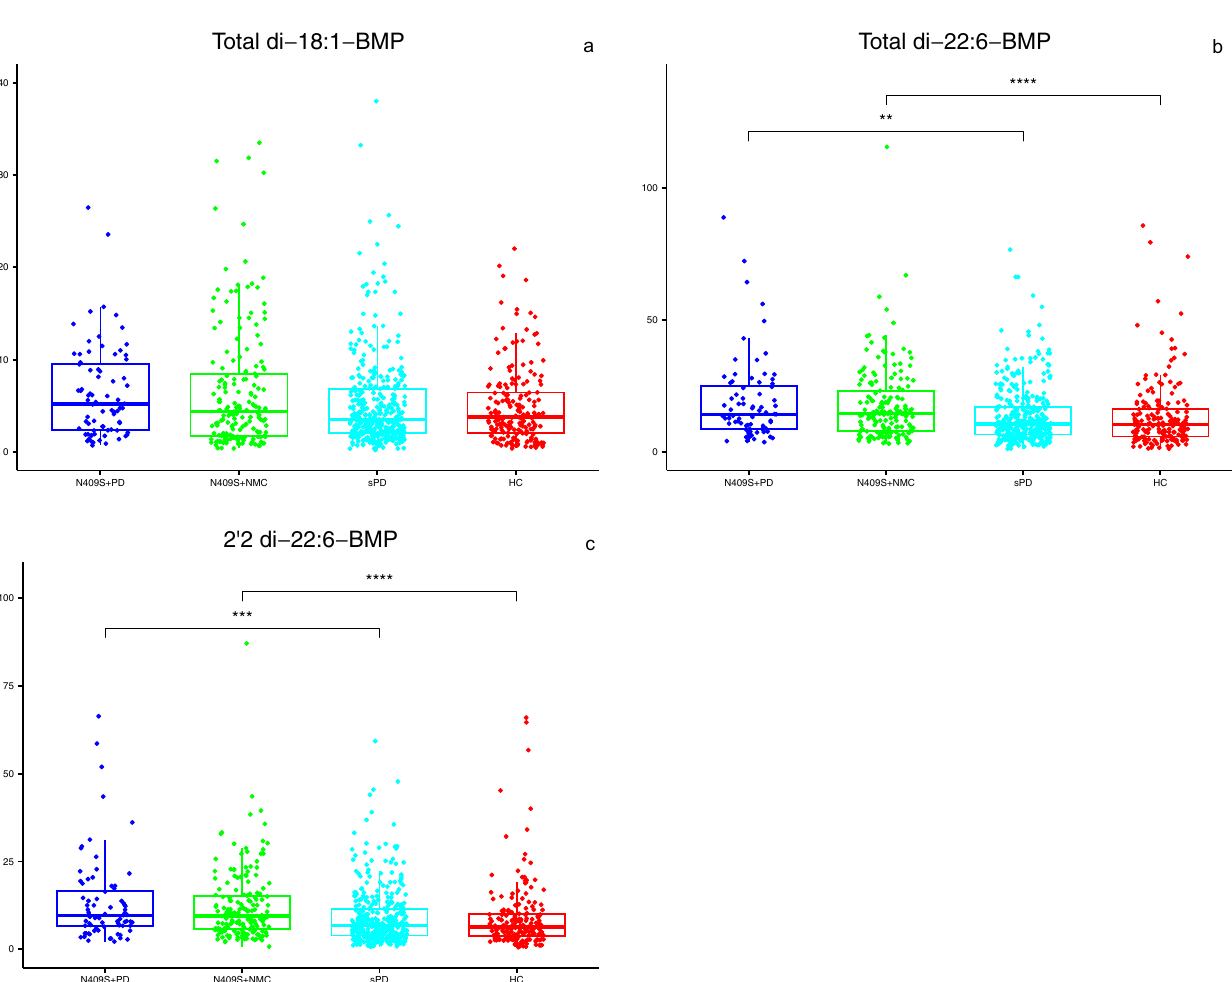
Fig. 2 Levels of three BMP isoforms in GBA1 N409S carriers compared to HC and sPD. a – c Plots show baseline concentrations of each speci fi c BMP isoform measured in the 4 groups indicated on the X -axis. Box-and-whisker plots with scatter plots superimposed are shown with fi lled circles representing observed data. The bottom and top edges of the box correspond to the 75th and 25th percentiles, respectively. The horizontal line within the box indicates the median. The whiskers indicate the range of values within 1.5 times the interquartile range. Mann – Whitney U -test was used for pairwise comparisons. The signi fi cance level for pairwise comparisons is p value <0.0125 (after Bonferroni correction). **** p value <0.0001, *** p value <0.0005, and ** p value